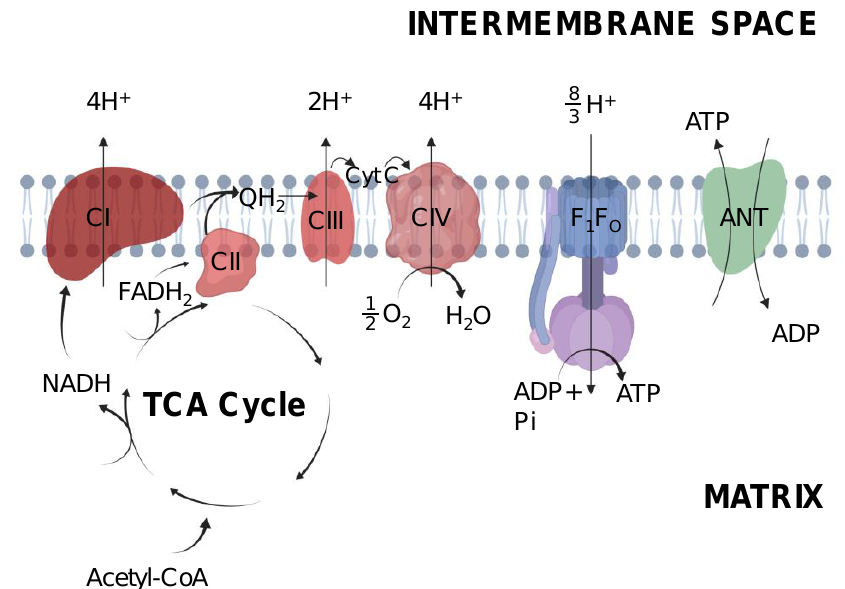
Figure 1. Mitochondrial oxidative phosphorylation. Mitochondria produce reducing equivalents through the tricarboxylic acid (TCA) cycle within the mitochondrial matrix. Reducing equivalents (NADH, FADH 2 ) contribute to the electron transport system at complex I and II, respectively. Donation of electrons provides the energy to pump protons to generate the proton motive force (pmf). This pmf is utilized by the F 1 F O ATP synthase in the production of ATP which is translocated to the intermembrane space through the adenine nucleotide translocase (ANT). The proton pumping stoichiometries are given as “effective” protons per pair of electrons. Created with Biorender.com.